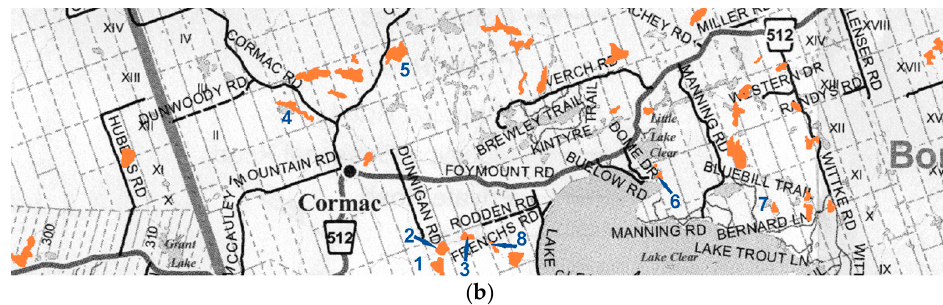
Figure 1. ( a ) Study area, outlined in yellow, at the southern edge of the upper Ottawa Valley, Ontario. The yellow frame marks the location of the larger-scale map. ( b ) Enlarged view of the study area. Study wetlands are shown in orange, with wetlands with quantitative water level monitoring numbered in blue.